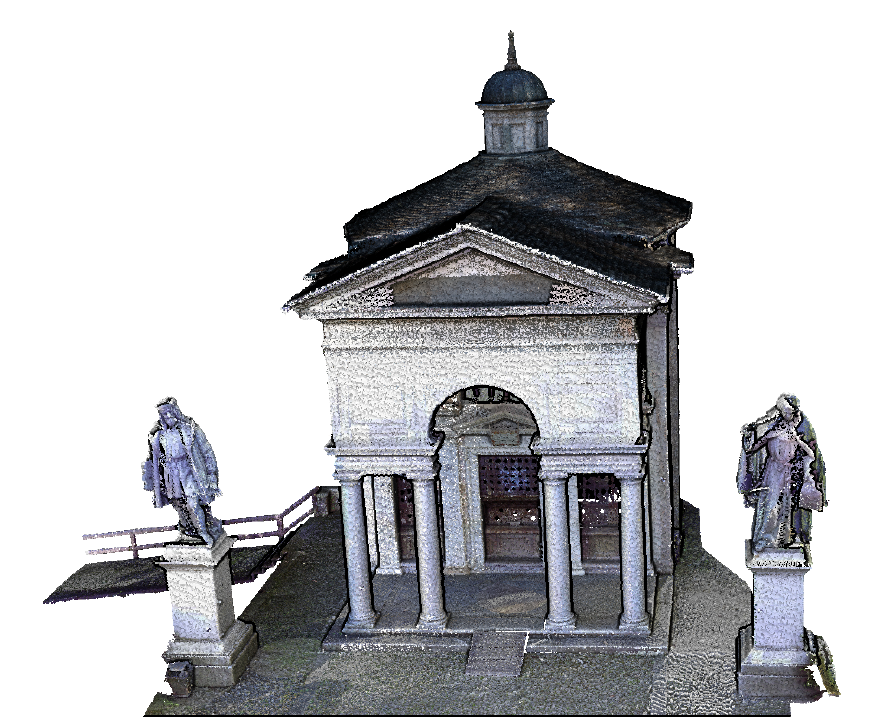
Figure 6. Original point cloud of the first chapel of Sacro Monte.